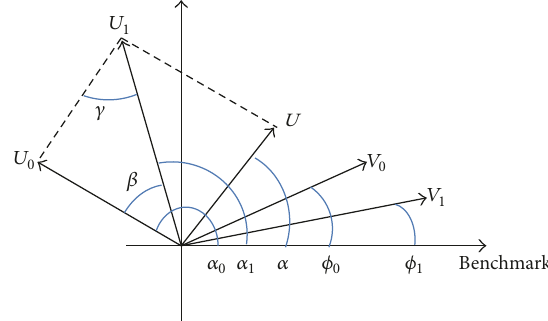
Figure 5: The vector relation between the exciting factors and